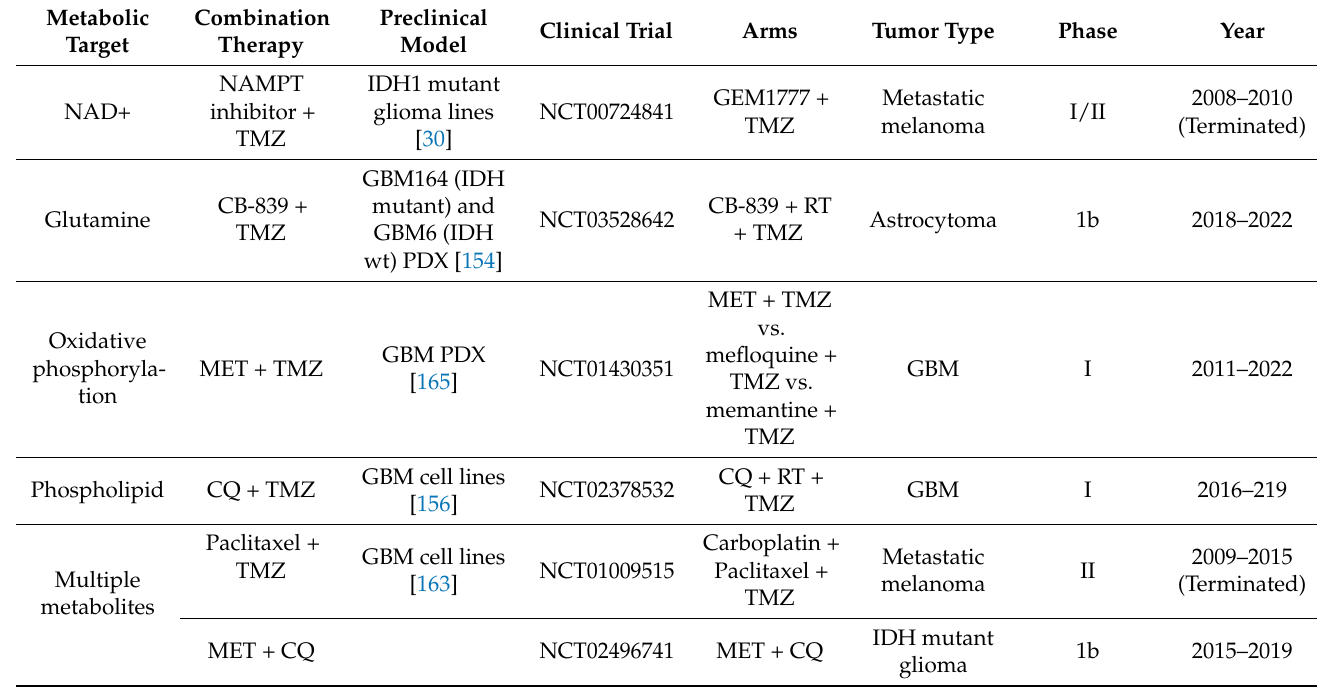
Table 4. Preclinical and clinical studies of TMZ combined with therapies targeting cancer